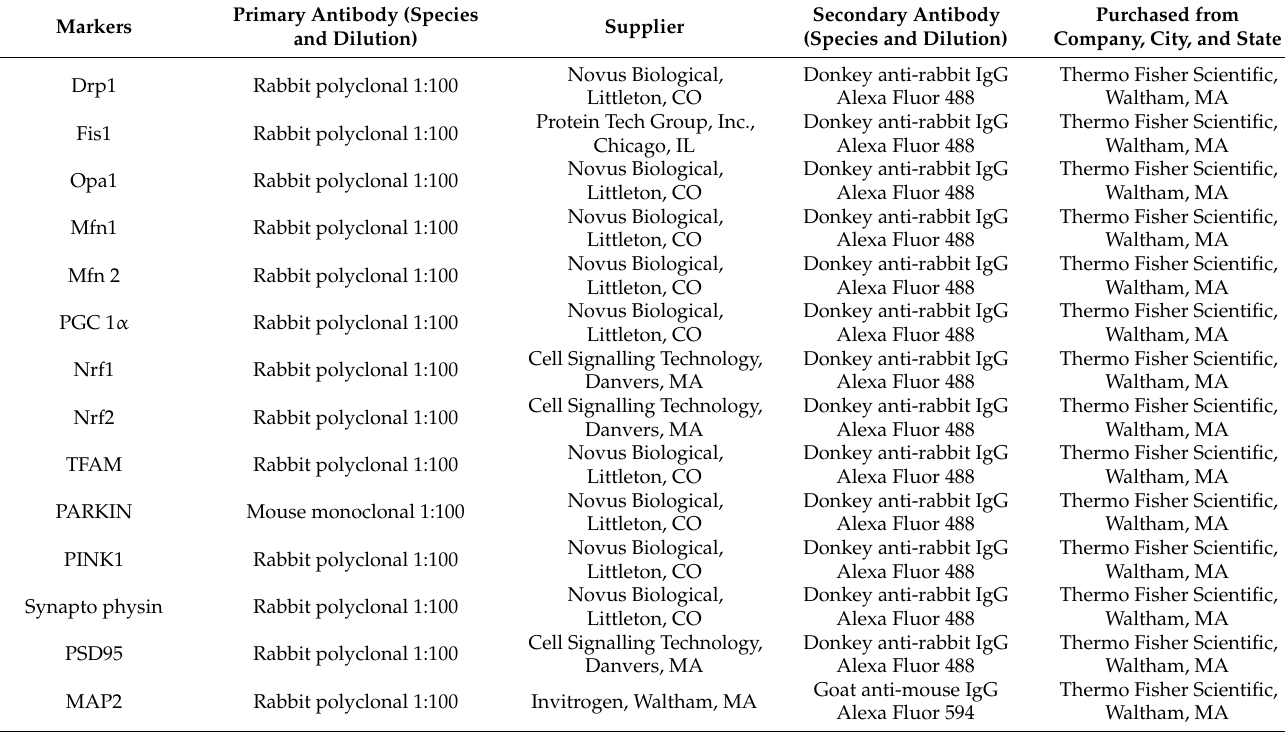
Table 3. Summary of the antibody dilutions and conditions used in the immunofluorescence analysis of the mitochondrial dynamics, mitochondrial biogenesis, synaptic, autophagy, and mitophagy proteins in the brain sections of non-diabetic mice, chaya-fed mice, and regular chow-fed diabetic TH